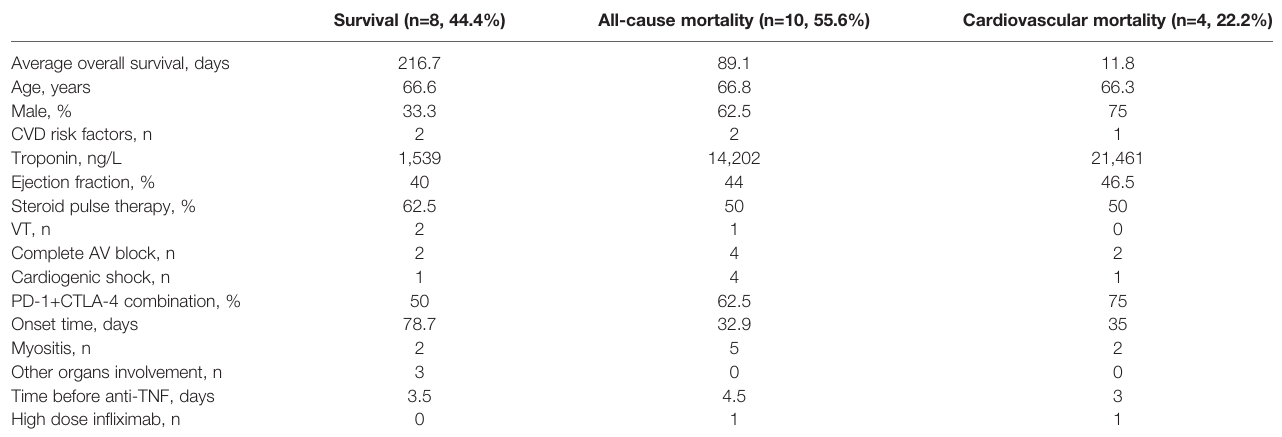
TABLE 3 | Comparison between survivors and non-survivors. Survival (n=8, 44.4%) All-cause mortality (n=10,